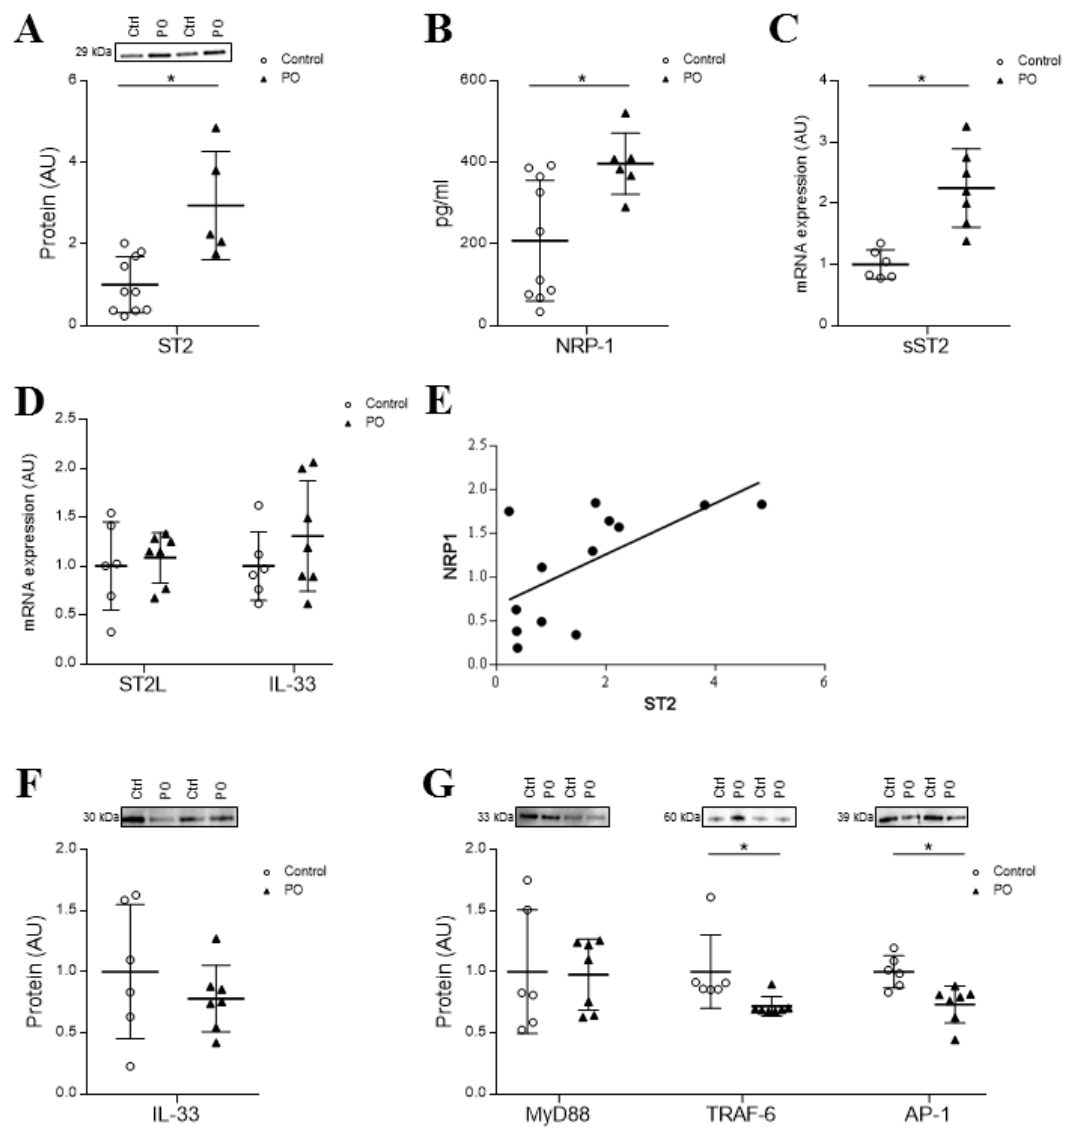
Figure 6. Cardiac expression of ST2 and NRP-1 in a pressure overload (PO) rodent model. Cardiac protein ST2 ( A ), NPR-1 protein expression ( B ) and sST2 mRNA ( C ) in myocardium samples of controls and PO rats. Gene expression of ST2L and IL-33 ( D ). Correlation between ST2 and NRP-1 expression (r = 0.633, p = 0.02) ( E ). E ff ects of PO on IL-33 protein ( F ) and MyD88, TRAF-6 and AP-1 protein expressions ( G ). Scatter dot blot represents the median and minimum to a maximum range of N = 5–10 animals per group. For Western blot experiments, protein densitometry was expressed in arbitrary units (AU) once normalized to stain-free for proteins. Relative mRNA expression was expressed in arbitrary units (AU) of fold change after normalization to HPRT, β -actin and GADPH housekeeping genes. Representative blots have been displayed when appropriate. * p < 0.05 vs. control group. ST2, interleukin 1 receptor-like 1; NRP-1, neuropilin-1; IL-33, interleukin 33; MyD88, Myeloid di ff erentiation primary response 88; TRAF-6, tumor necrosis factor receptor associated factor 6 and AP-1, activator protein